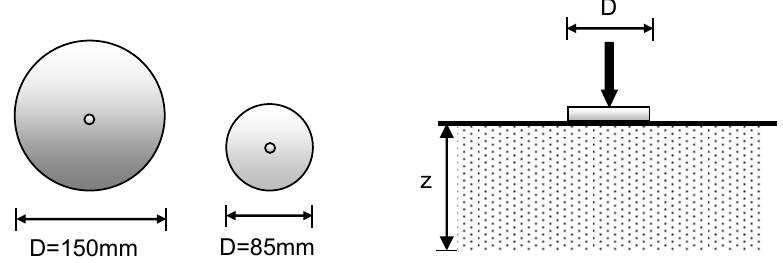
Figure 3. Model footings and geometric parameters of model test.